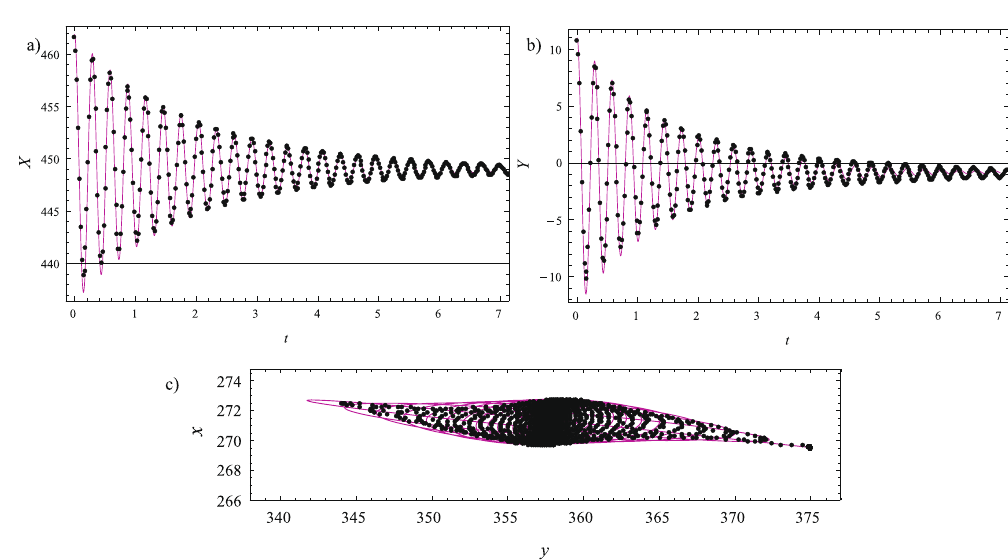
Figure 9. Marker 2: ( a ) Comparison of the transformed experimental results (magenta solid line) and the fitted numerical results (black dots) along the X -axis; ( b ) Comparison of the transformed experimental results (magenta solid line) and the fitted numerical results (black dots) along the Y -axis; ( c ) Comparisons for the